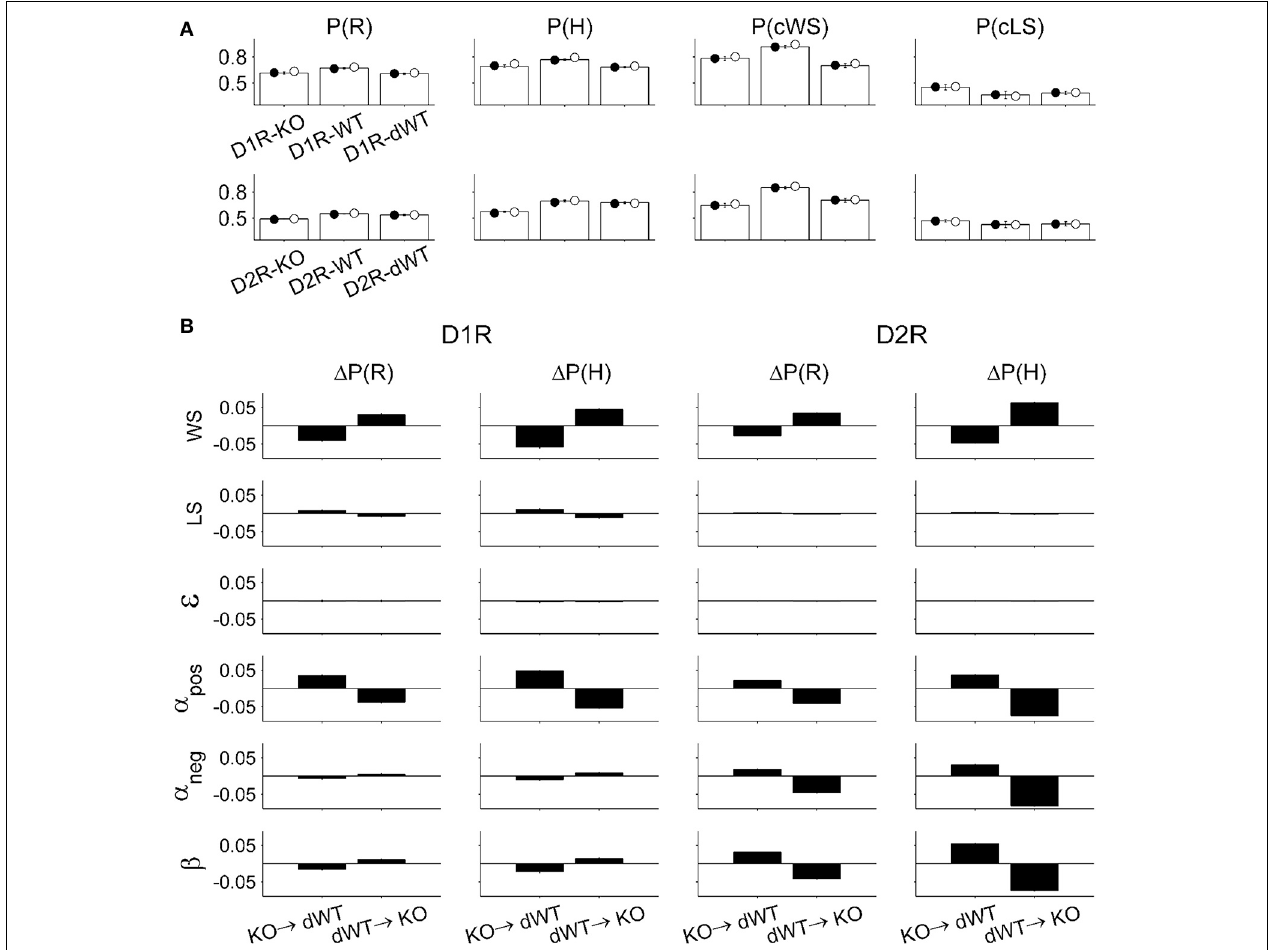
FIGURE 7 | Model prediction. (A) Animal’s choices were simulated with the full model. P(R), the proportion of rewarded choices; P(H), the proportion of choosing the higher arming-probability goal in each block; P(cWS), the proportion of repeating rewarded choice in the previous trial; P(cLS), the proportion of switching from unrewarded choice in the previous trial. Open bars, actual choice data (mean ± s.e.m. across animals); filled circles, choices were predicted using model parameters estimated for individual animals (mean across animals); open circles,